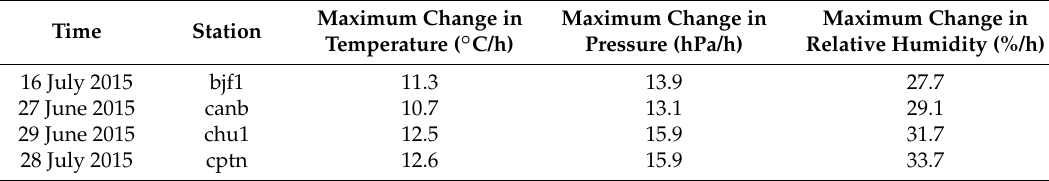
Table 1. The most serious troposphere anomalies at eight iGMAS stations in